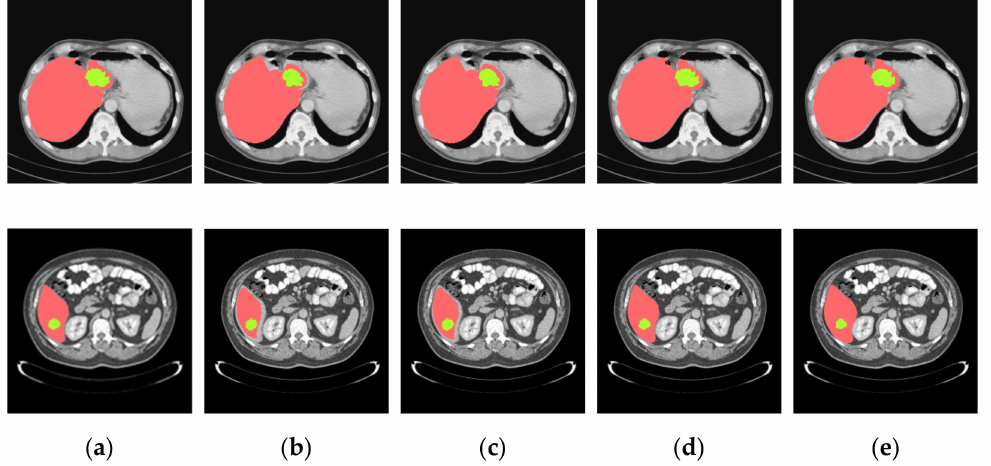
Figure 6. Segmentation results for the liver and tumors of pattern one. ( a ) Ground truths, ( b ) U-Net, ( c ) U-Net + ADenseNet1, ( d ) U-Net + ADenseNet2 and ( e ) cascaded